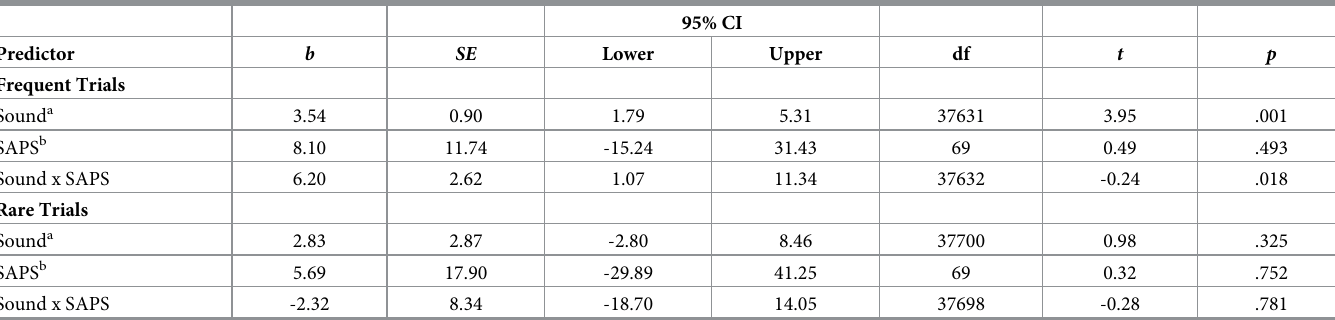
Reaction times on the oddball task as a function of sound condition (smartphone vs. control) and smartphone addiction with separate results for frequent and rare trials. a Sound condition was contrast coded at -.5 for control sound and .5 for smartphone sound.